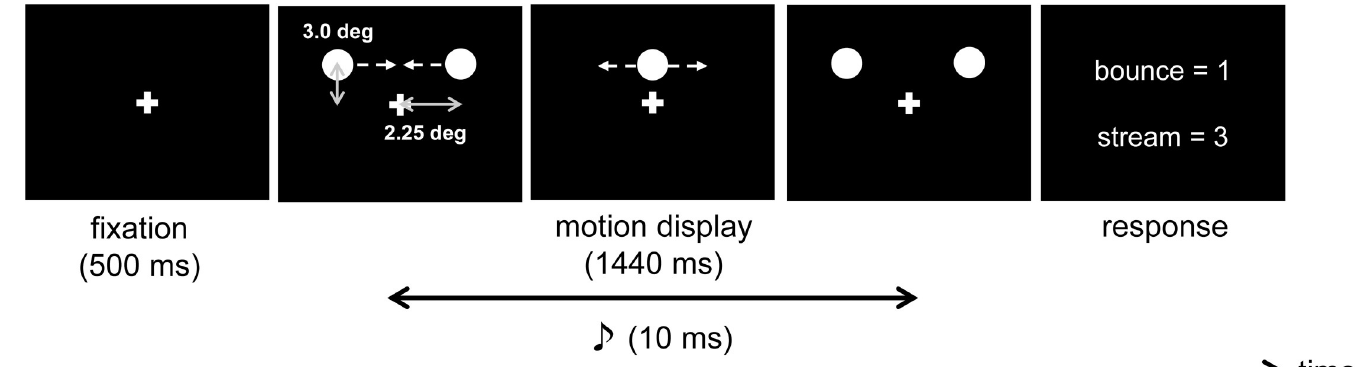
Fig 6. The schematic representation of the procedure used in the stream/bounce